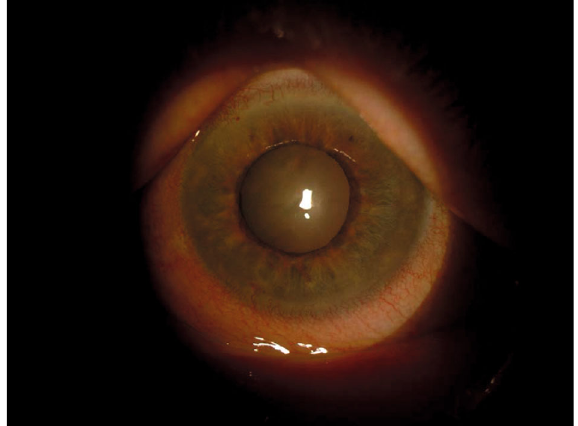
Figure 6: Slit-lamp image of the left eye fi ve days after the cessation of alfa-2b interferon therapy with almost complete disappearance of the